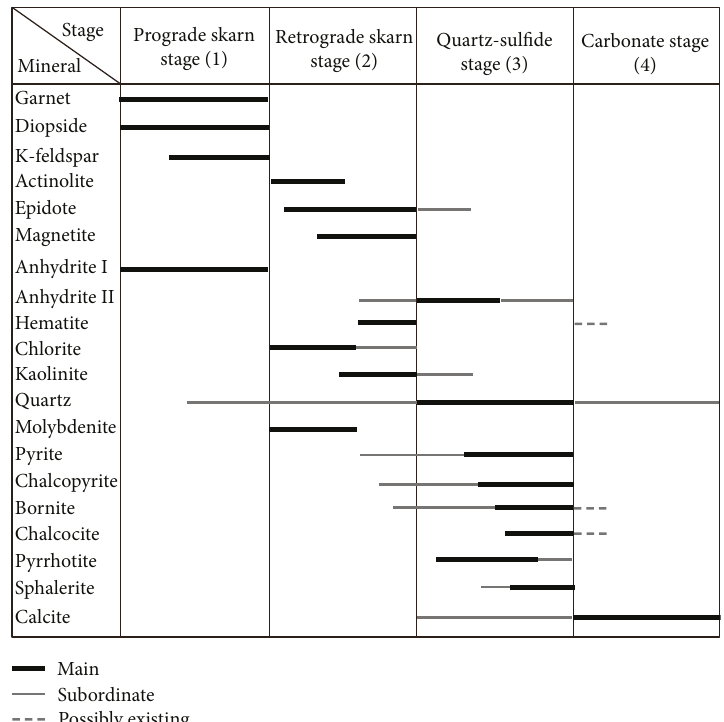
Figure 7: Paragenetic sequence diagram for the minerals in the Fuzishan